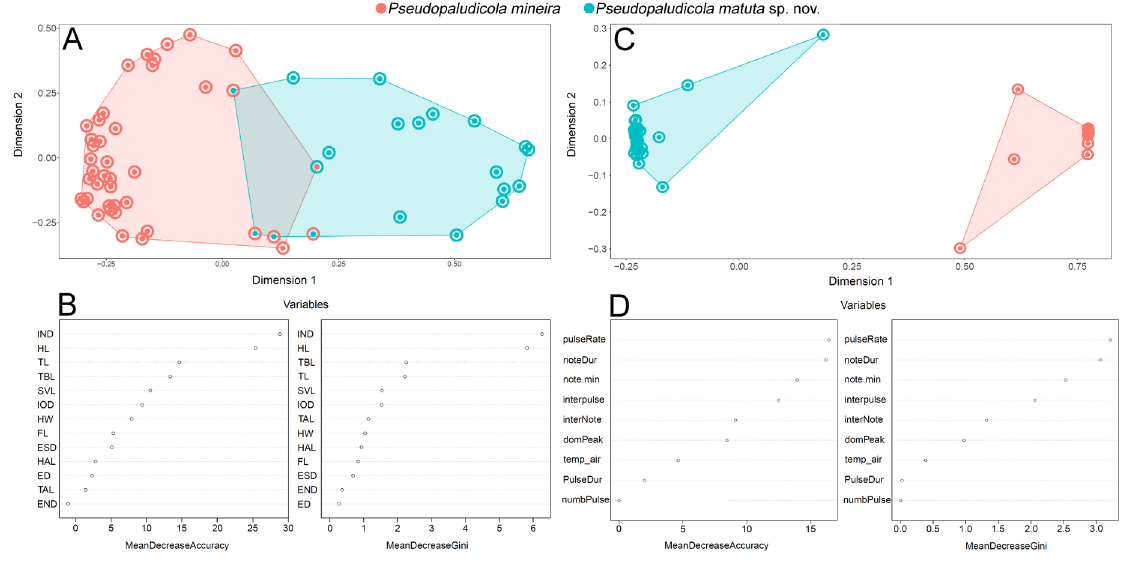
Fig. 5. First and second dimensions of the Multidimensional scaling on the proximity scores from the Random Forest analysis considering morphometric ( A ) and acoustic ( C ) traits of adult males of Pseudopaludicola matuta sp. nov. (blue dots) and P. mineira Lobo, 1994 (red dots). Dotcharts of variable importance score considering morphometric ( B ) and acoustic ( D ) traits as indicated by the Random Forest analysis. Each dot represents an adult